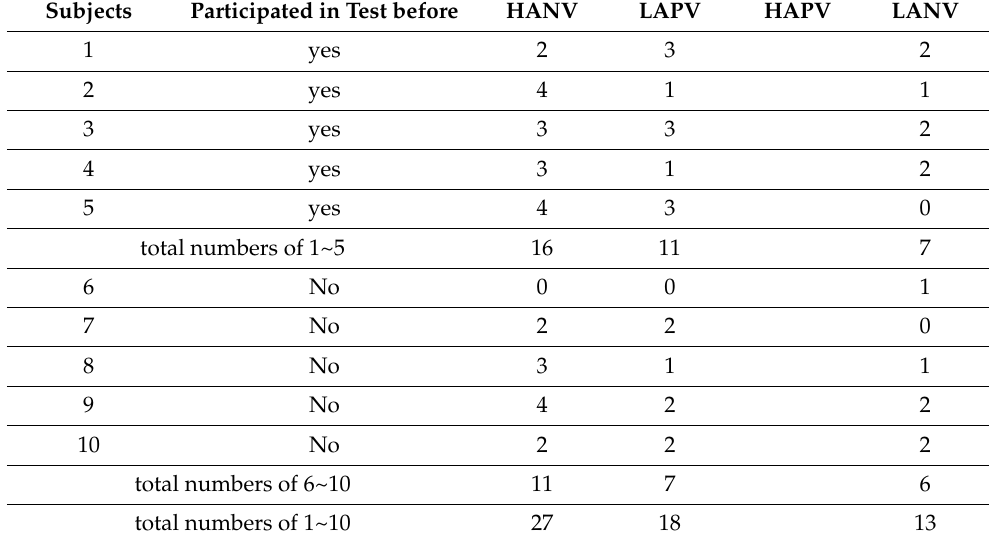
Table 2. The number of the subject’s activated emotions with Approach